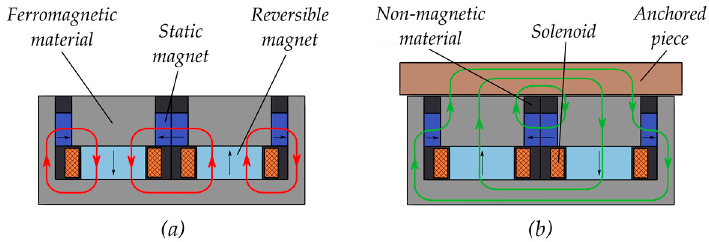
Figure 2. The typical EP configuration in ( a ) rest and ( b ) working conditions.